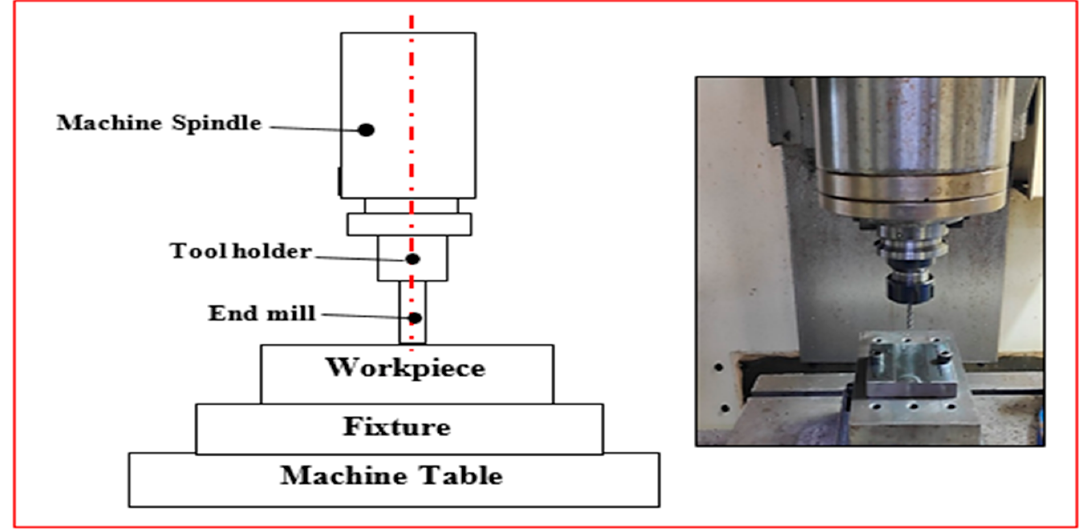
Figure 2. Trochoidal tool path step simulation at ( a ) s tr = 0.6 mm ( b ) s tr = 1.2 mm ( c ) s tr = 1.8 mm.